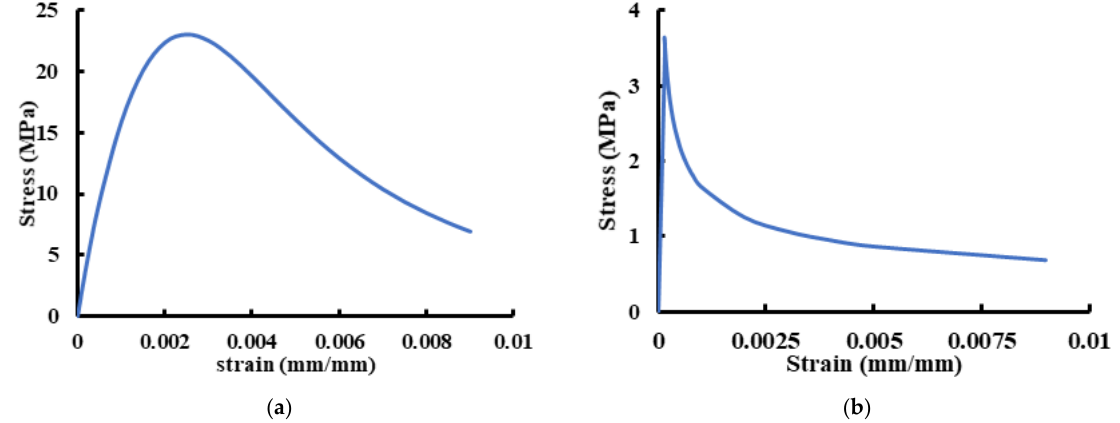
Figure 8. Concrete uniaxial compressive and tensile stress–strain curves. ( a ) In compression; ( b ) in tension. Table 5. Parameters of the CDP model used in ABAQUS.